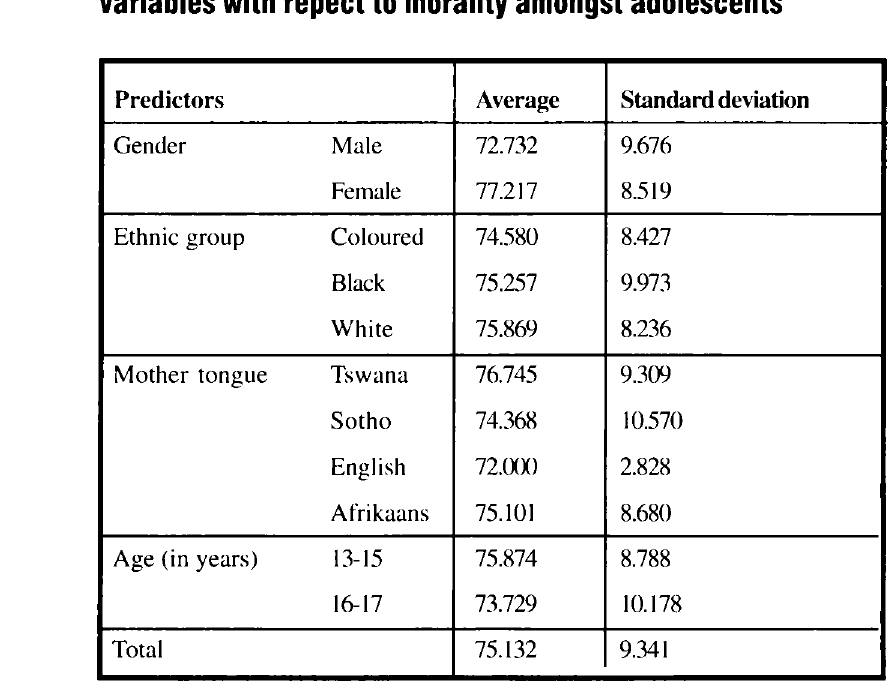
Table 4: Averages and standard deviations of the biographical variables with repect to morality amongst